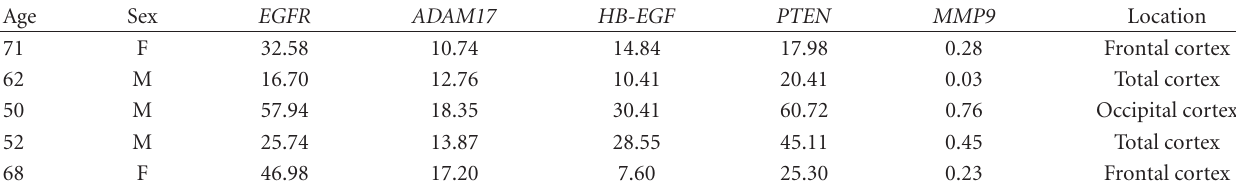
Table 3: Age, gender, mRNA expression values (in femtograms), and anatomical location of normal brain specimens.